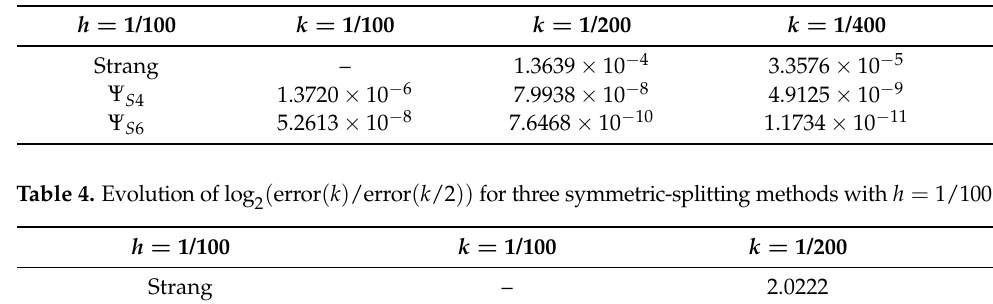
Table 3. Time error for three symmetric-splitting methods with h = 1/100 for final time T = 1. h = 1/100 k = 1/100 k = 1/200 k = 1/400 Strang –